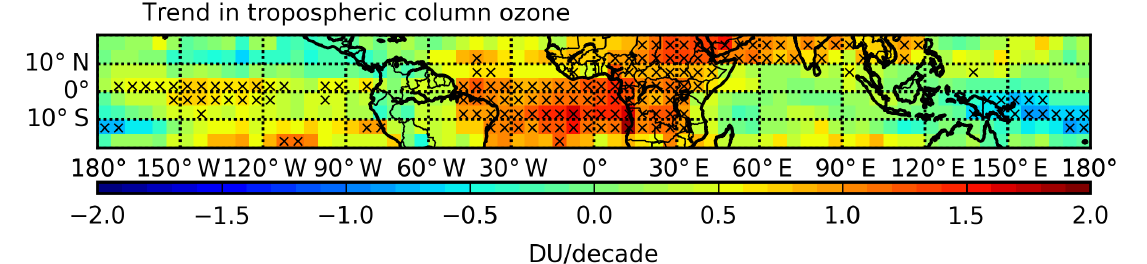
Figure 9. Tropical map of the tropospheric ozone trends. The crosses indicate regions where trends exceed the 2 × σ fit error. Overall the tropospheric ozone increased in the last 20 years. Only for New Guinea and the neighbouring Pacific Ocean a significant decrease is found.